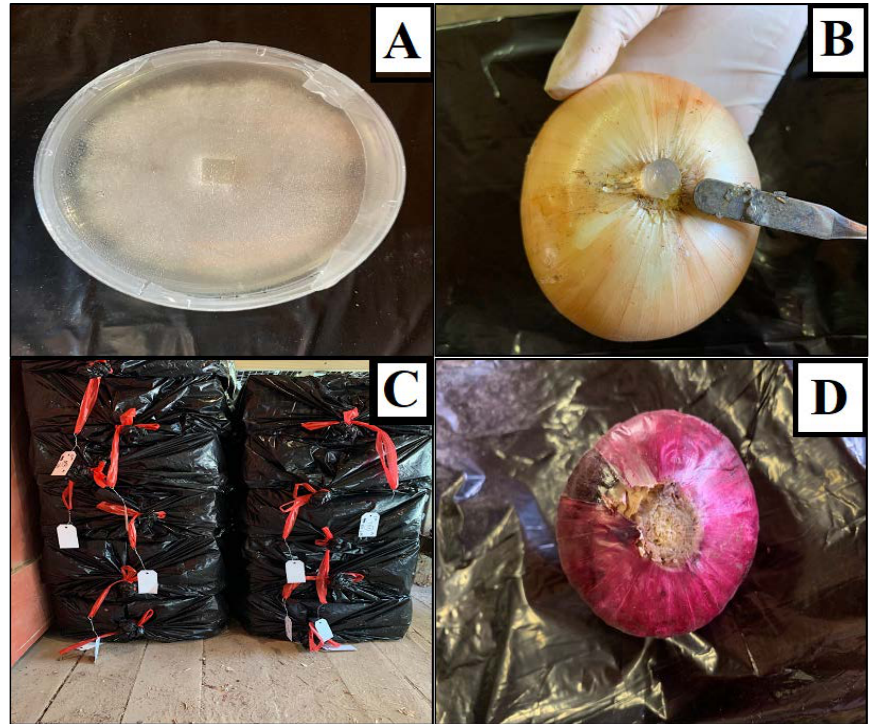
Figure 1. Conidial inoculation procedure for selection of Fusarium basal rot (FBR)-resistant onion bulbs ( A ) a culture of Fusarium oxysporum f. sp. cepae (FOC), ( B ) artificial inoculation of a transversely cut basal plate with conidia suspended potato dextrose agar (PDA) plug, ( C ) incubation of inoculated bulbs for ~24 h to create high humidity for disease development, ( D ) a susceptible onion bulb with a rating of